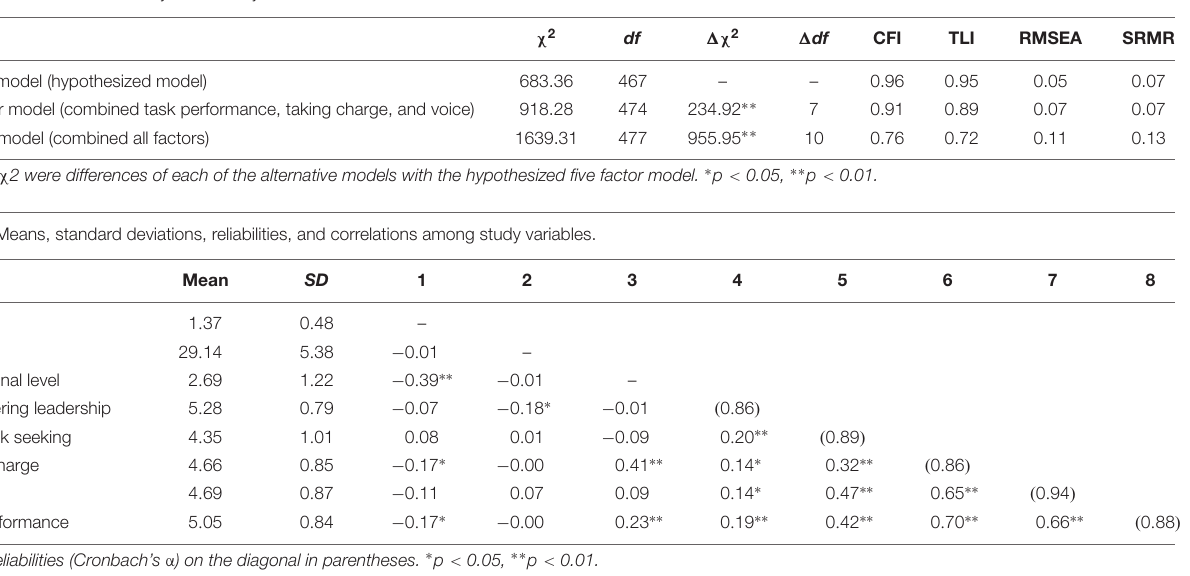
TABLE 1 | Results of confirmatory factor analyses.